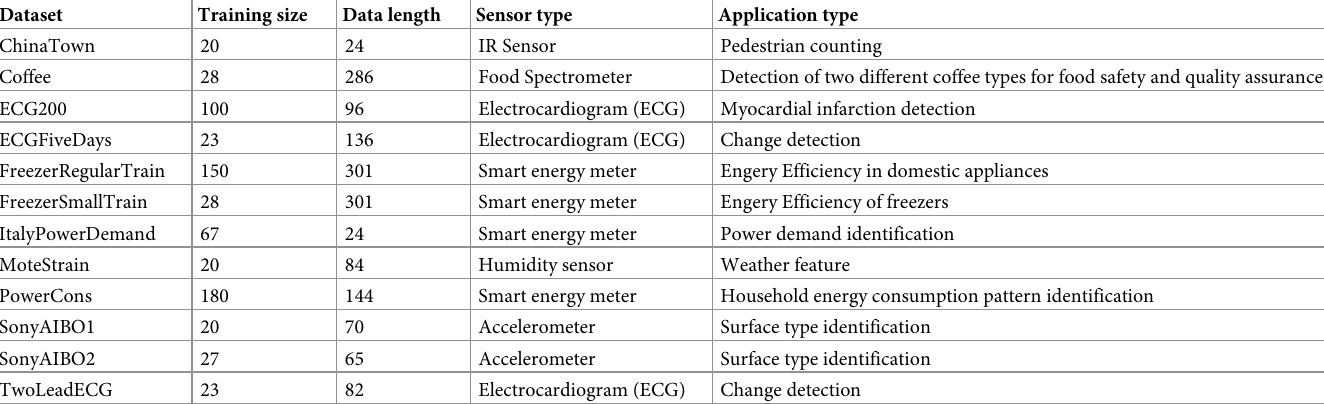
Table 1. Experimental dataset